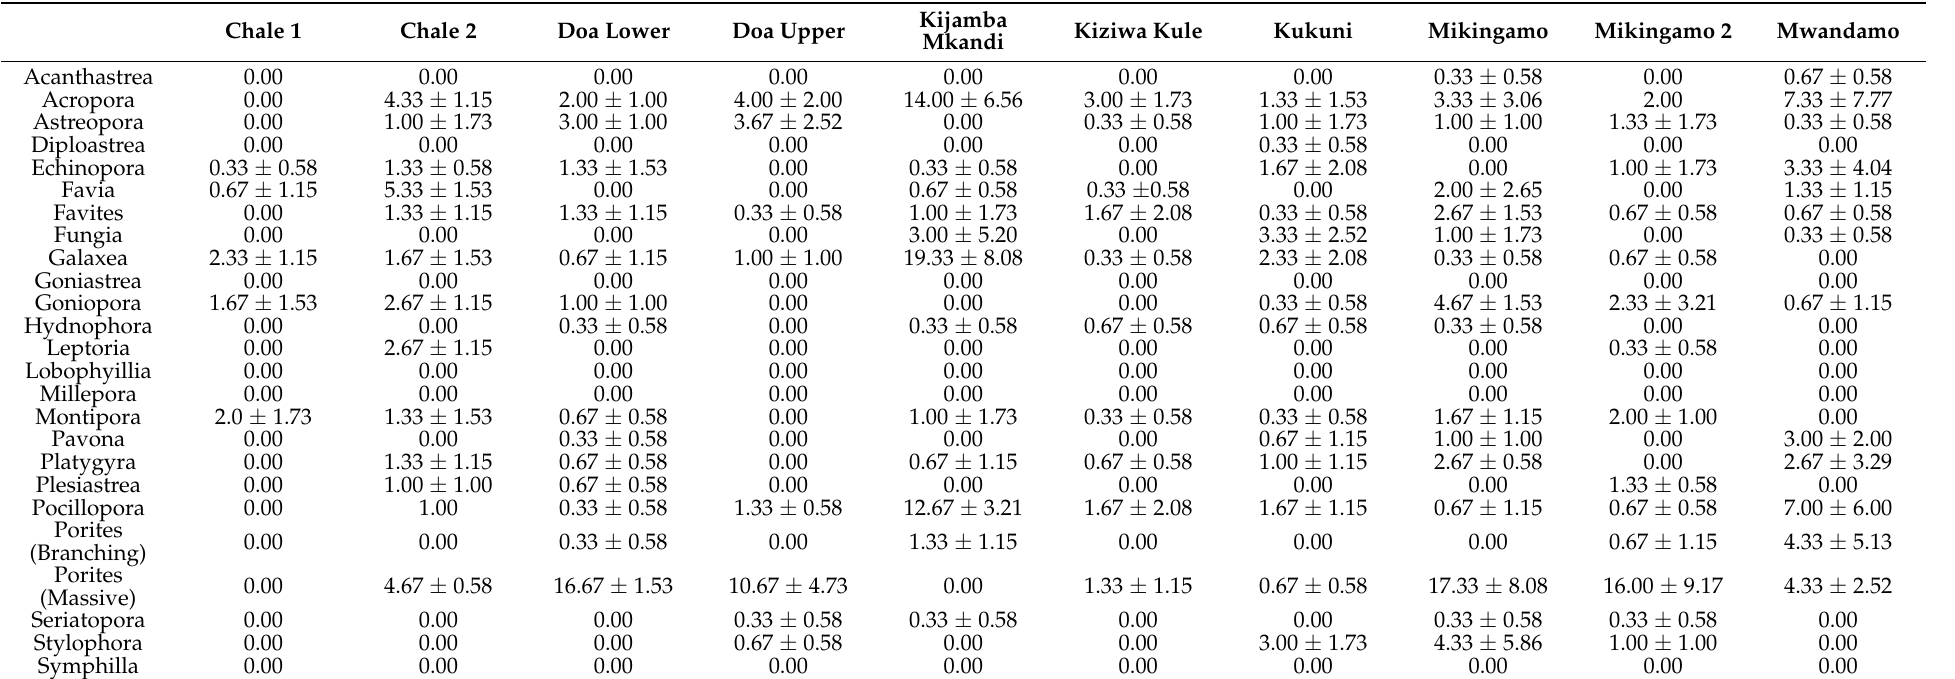
Table 2. Mean number of coral colonies for different genera per site ± standard